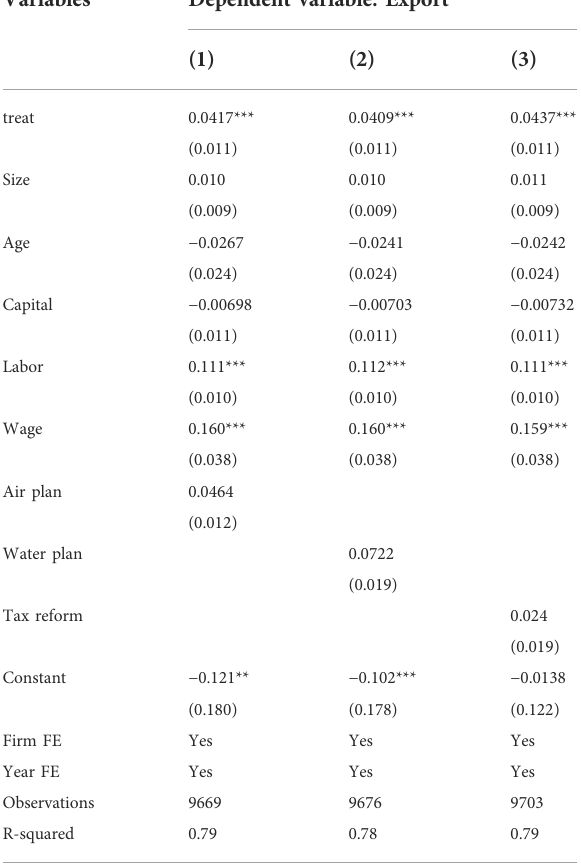
TABLE 4 The result of excluding the in fl uence of other interfering